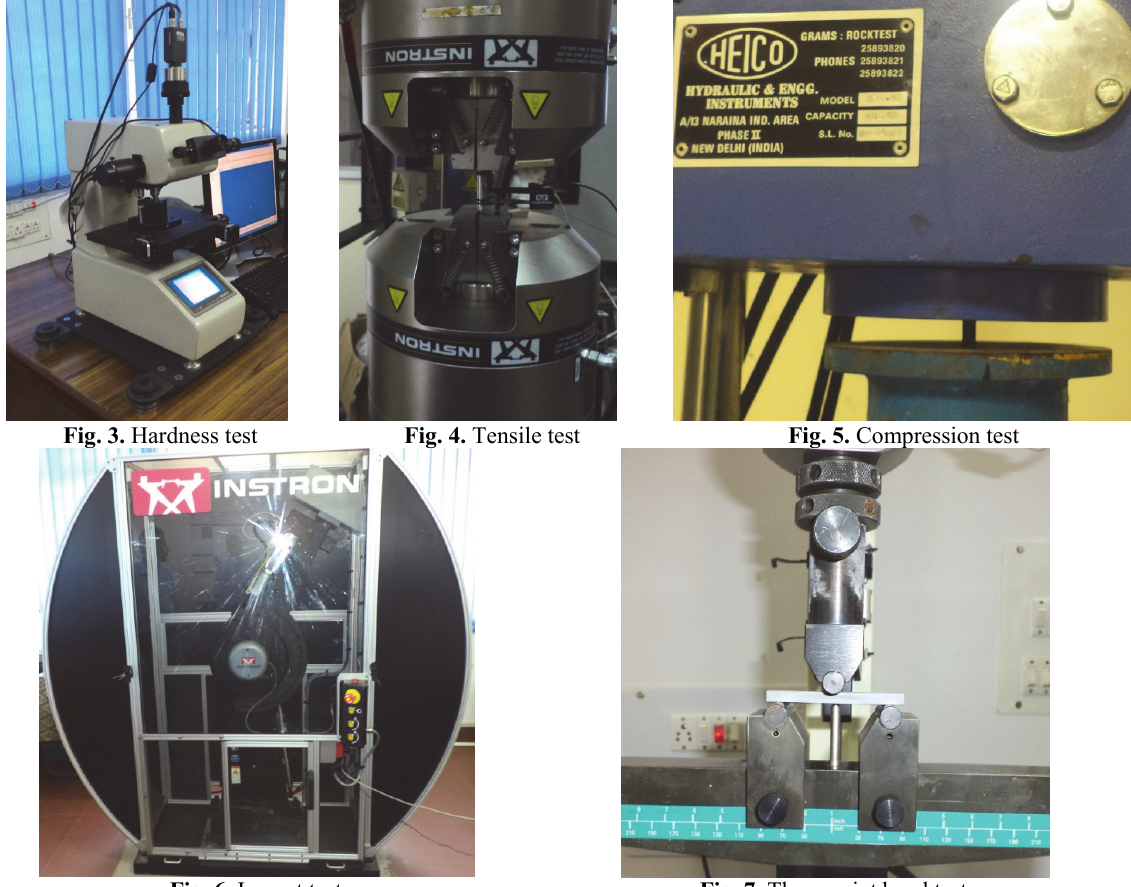
Fig. 6. Impact test Fig. 7. Three point bend